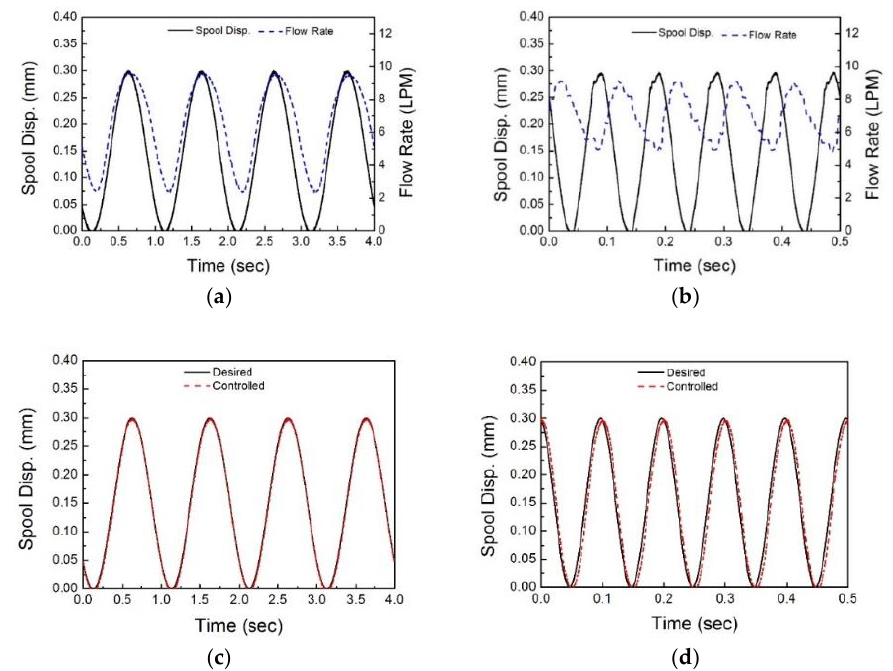
Figure 10. Tracking control results via PID controller at 30 °C , (a) Results from displacement sensor and flow meter at 1 Hz (b) Results from displacement sensor and flow meter at 10 Hz (c ) Tracking control at 1 Hz, (d) Tracking control at 10 Hz.